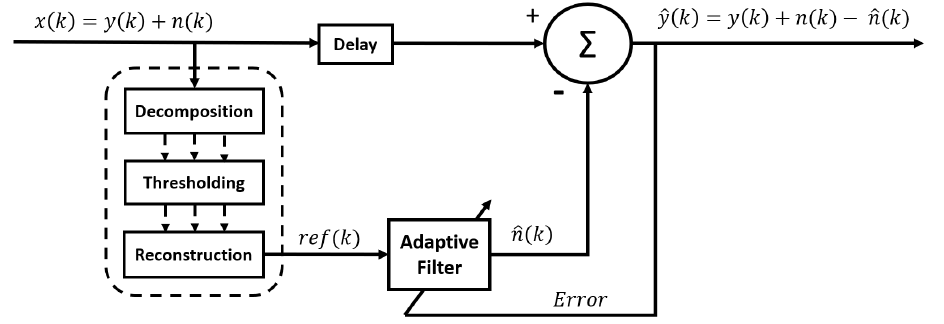
Figure 13. Block diagram of adaptive filtering using wavelet transform on the raw signal to estimate the